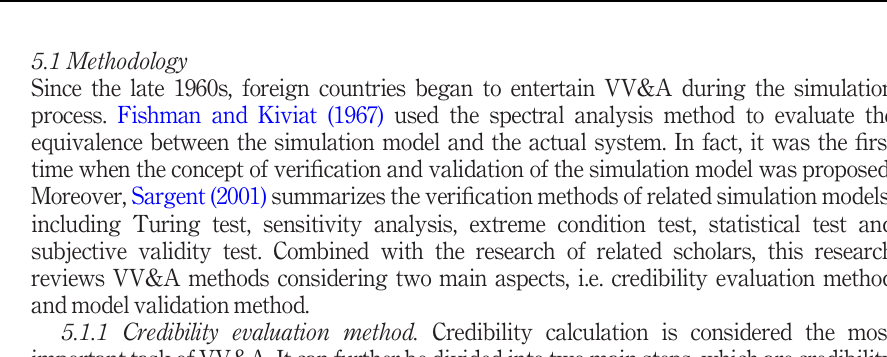
Table II. Summary of VV&A